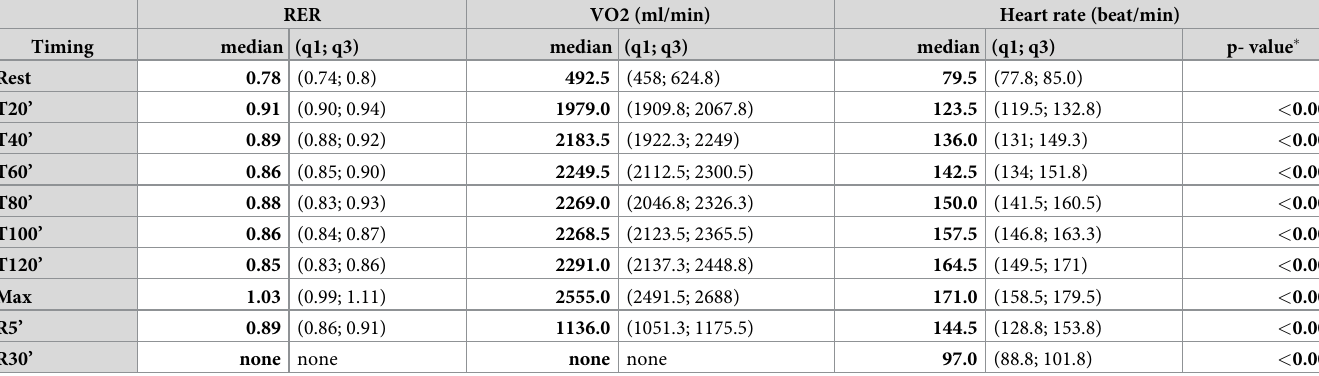
Table 5. Respiratory exchange ratio, VO 2 and heart rate values during the long dehydration